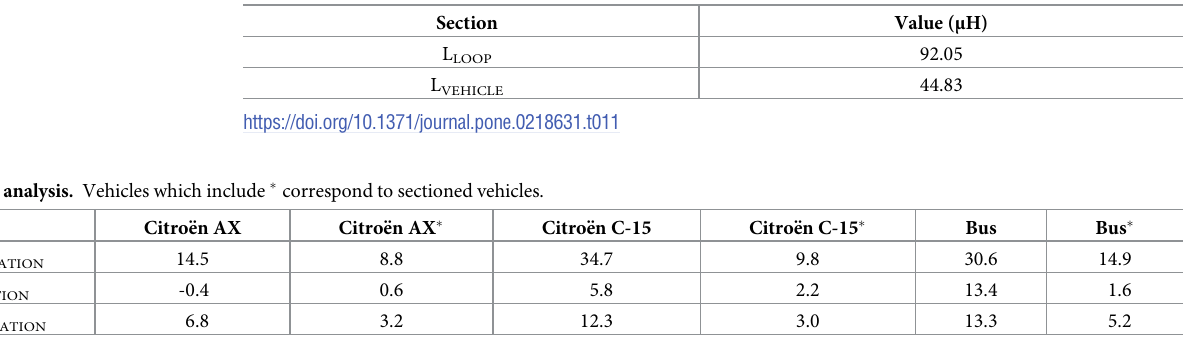
Table 11. Results for Bus.